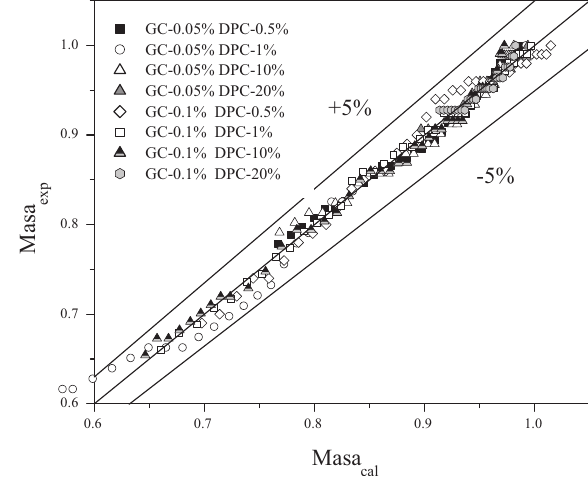
Fig. 5. Correlation between experimental values (massexp) and calculated (masscal) by means of the modified Washburn equation for the first phase of the imbibition process